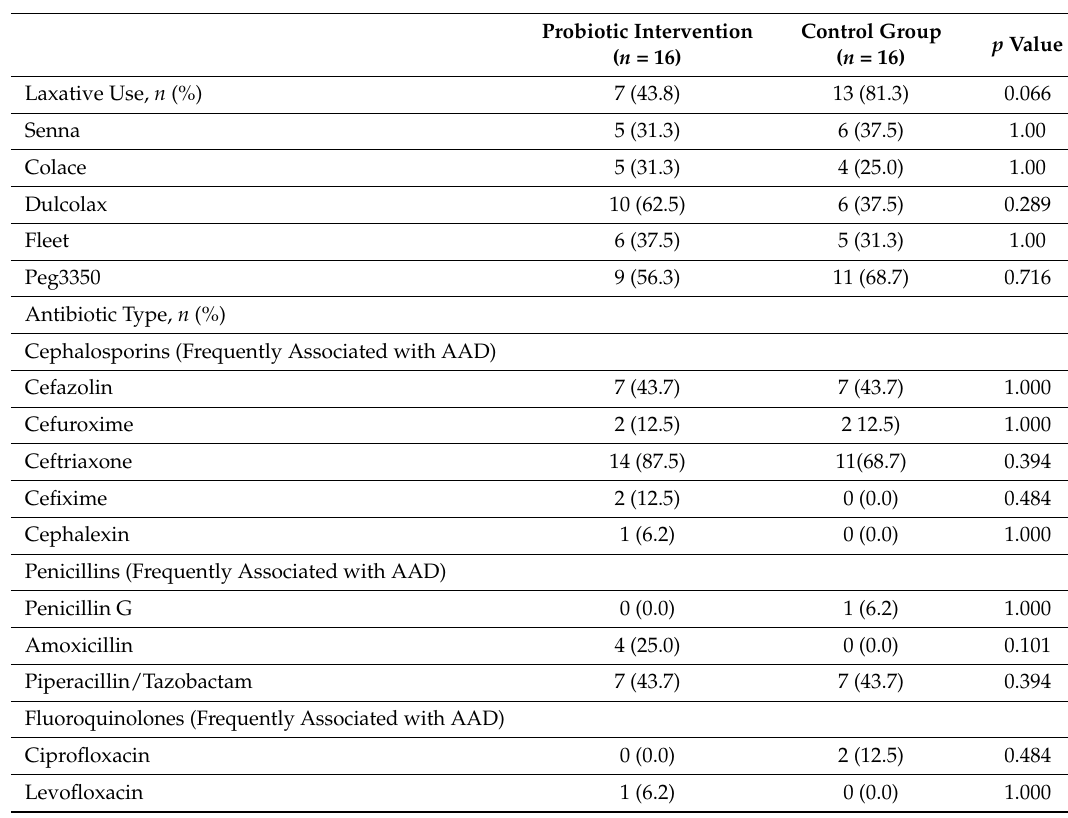
Table 2. Medication Use during ICU